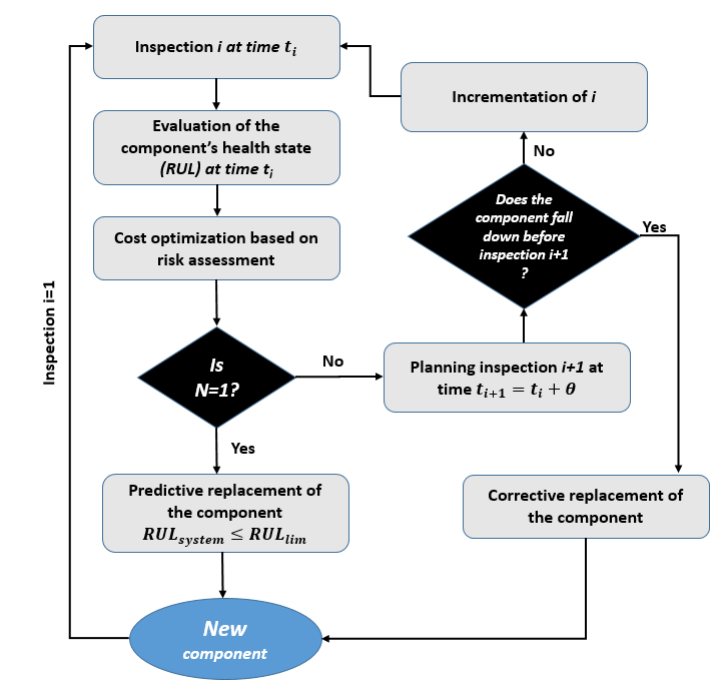
Figure 2. Flowchart of the optimization process for predictive maintenance